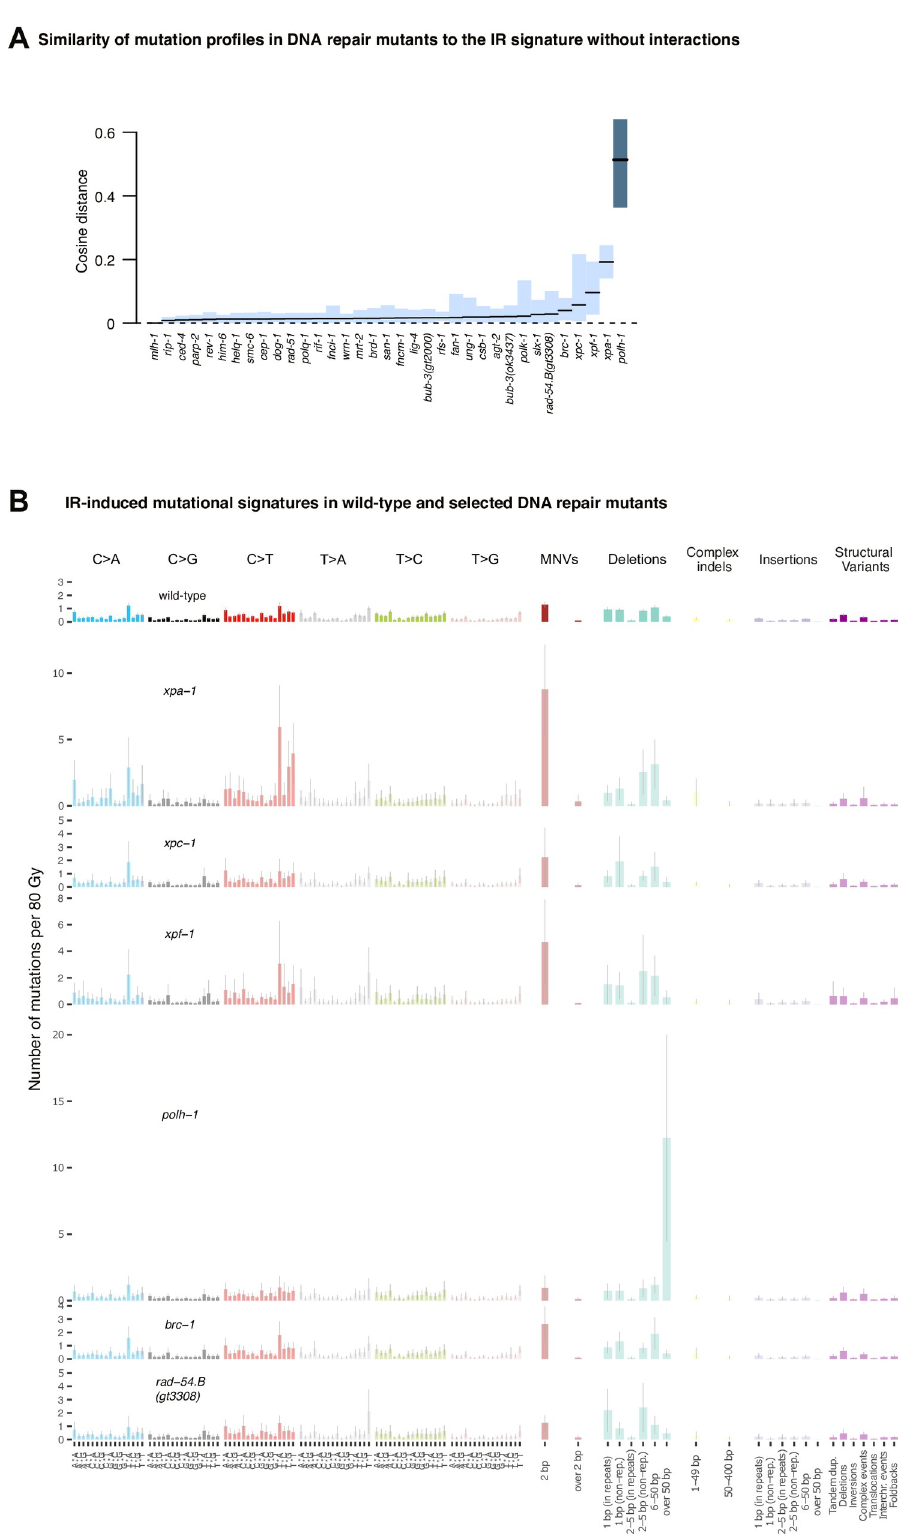
Fig 3. IR-induced mutation profiles of DNA repair mutants significantly different from wild-type. A. Similarity of IR-induced mutation profiles in DNA repair mutants compared to wild-type. The level of divergence from the